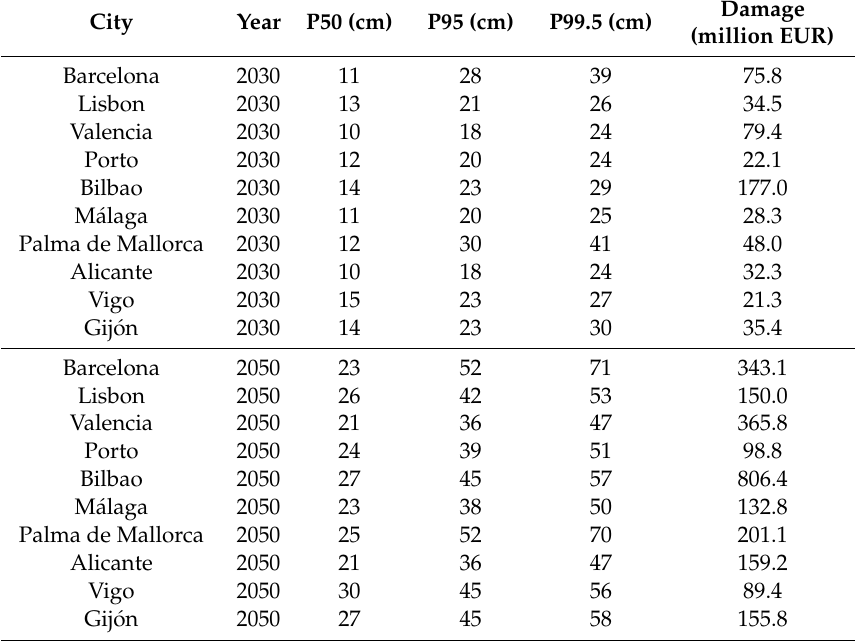
Table 1. Sea-level rise percentiles and accumulated damage costs in 2100 for those cities with the largest number of inhabitants under RCP